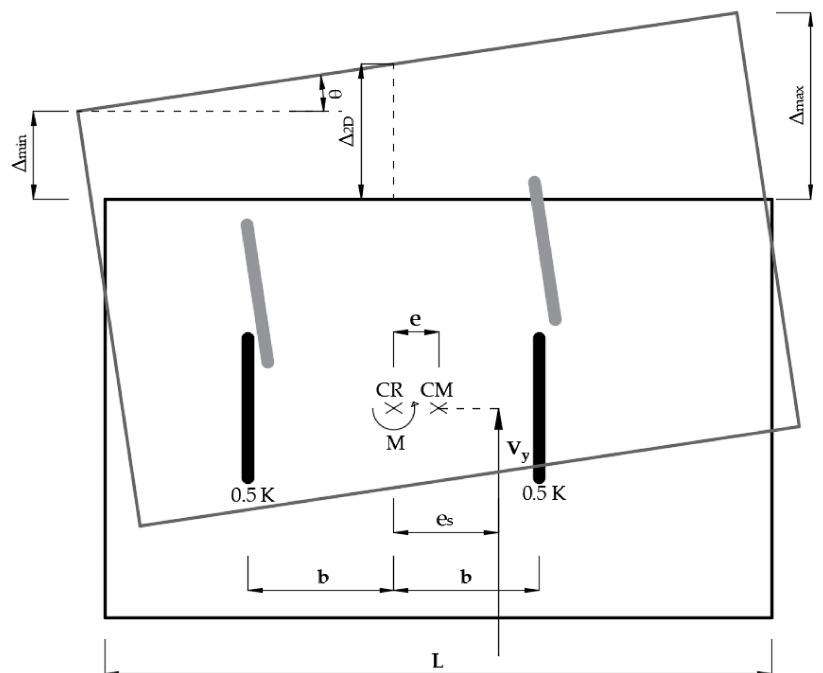
Figure 6. Detail of the frame pair (thick dark bands) and its spacing ( b ) in a rectangular building. Rotation of the frame pair and the building (final shape in grey colour) by angle θ on applying the lateral load V at a distance of e s from the centre of rigidity